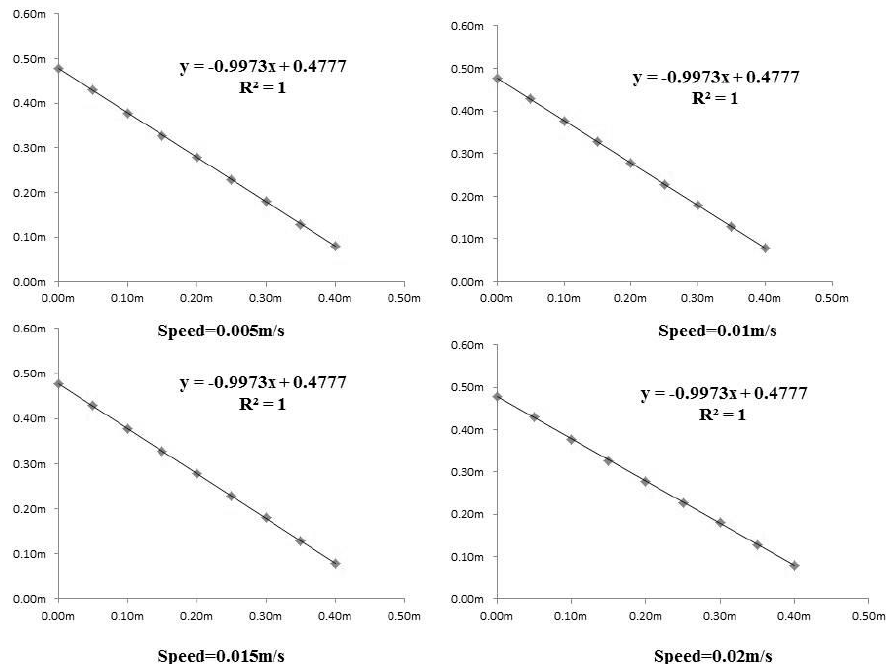
Figure 10. Vertical direction control test results at different speeds. Figure 9. Vertical direction control test results at different speeds. Sensors 2016 , 16 , 648